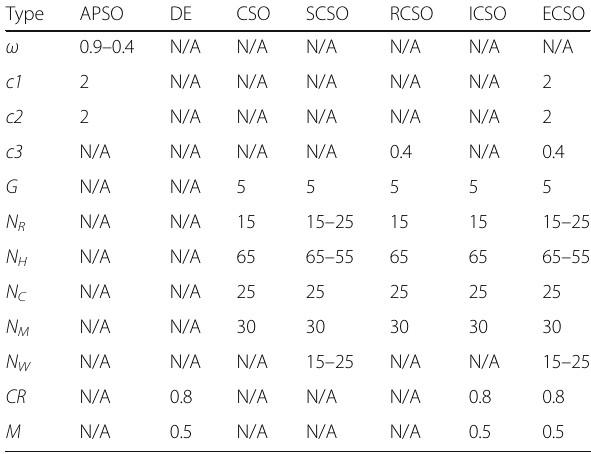
Table 2 Parameter settings for the seven